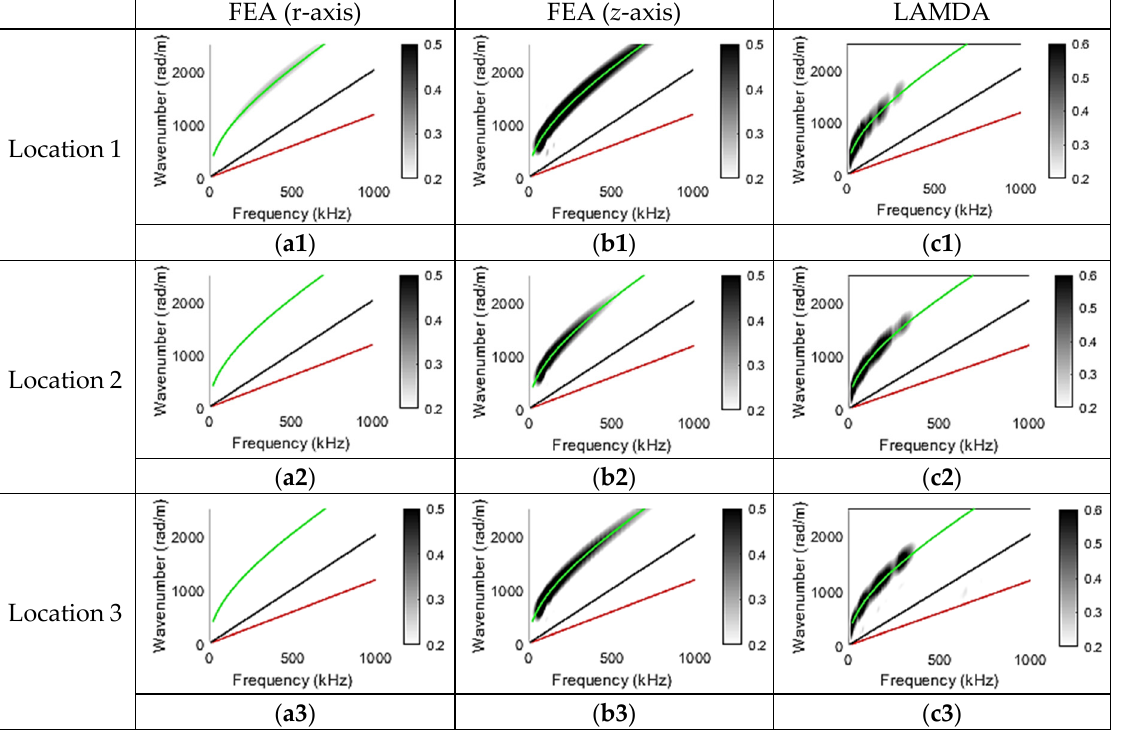
Figure 7. Transverse PLB results. Top row shows wavenumber–frequency plots corresponding to the radial component obtained from FEA, the out-of-plane component obtained from FEA, and from the LAMDA sensor at location 1. Middle row as for top row but for location 2. Bottom row as for top row but for location 3.